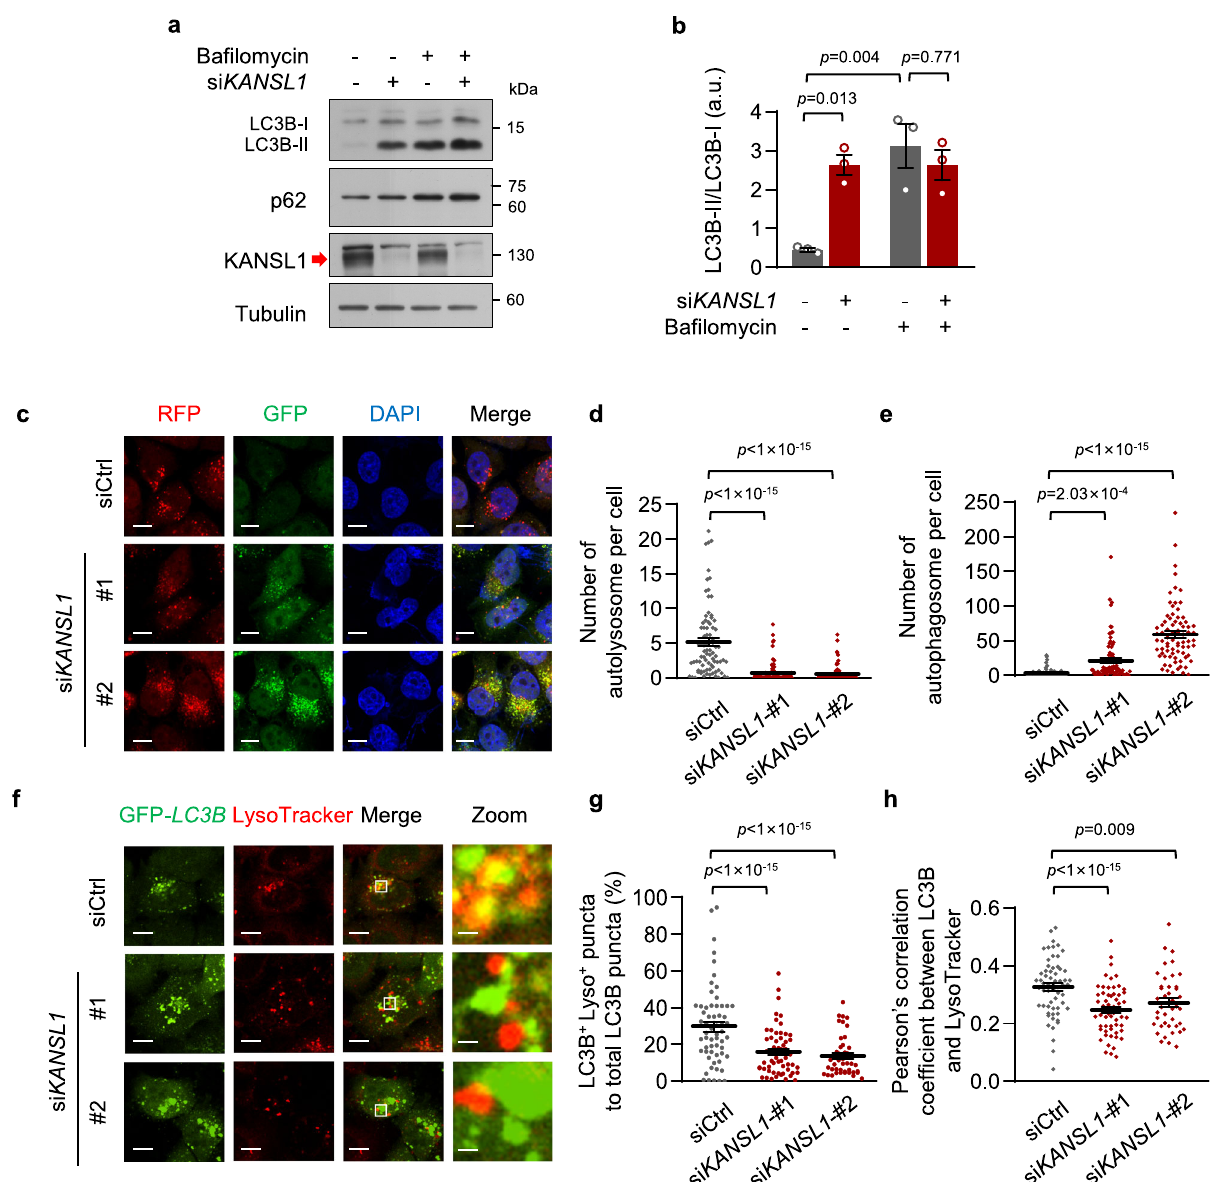
Fig. 2 KANSL1 de fi ciency impairs autophagosome-lysosome fusion. a Western blot analysis of HeLa cells transfected with siRNAs with the indicated antibodies. Cells were treated with or without 100 nM ba fi lomycin A1 for 12 h. The arrow indicated the KANSL1 protein band. b Quantitation of protein signal intensities from immunoblots in ( a ) showing the ratio of LC3B-II to LC3B-I ( n = 3 independent experiments). c Representative images of RFP-GFP- LC3B lentivirus-infected HeLa cells transfected with the indicated siRNAs following EBSS (6 h) treatment. Nuclei are labeled with DAPI (blue). Scale bar, 10 μ m. d , e Quanti fi cation of the number of autolysosome ( d ) or autophagosome ( e ) per cell in ( c ). n = 82, 83, 77 cells. f Representative confocal images of colocalization of GFP- LC3B puncta and acid lysosome (red, LysoTracker) in HeLa cells transfected with the indicated siRNAs after EBSS treatment for 6 h. g , h Quanti fi cation of the colocalization by calculating the percentage of LC3B + Lyso + puncta to total LC3B puncta ( g ) and Pearson ’ s correlation coef fi cient ( h ) in ( f ). n = 61, 58, 42 cells. Scale bar, 10 μ m and 1 μ m in “ Zoom ” . Source data are provided as a Source data fi le. All data are means± SEM. b One-way ANOVA with Tukey ’ s multiple hoc test; d , e , g , h by one-way ANOVA with Dunnett ’ s multiple hoc